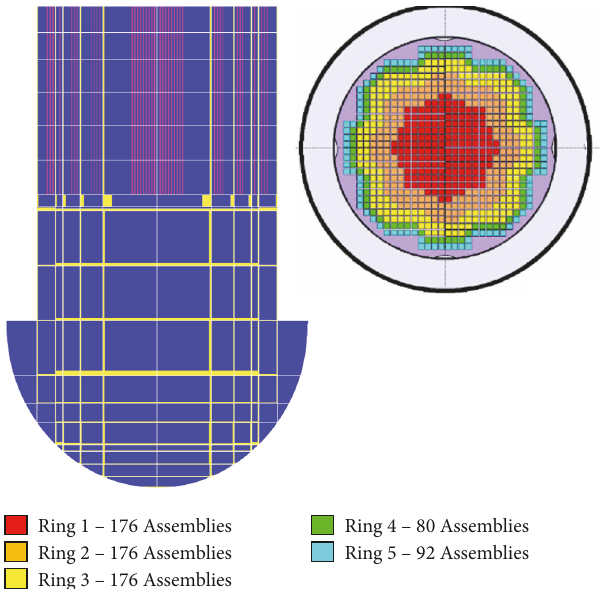
Figure 2: Nordic BWR MELCOR model. COR